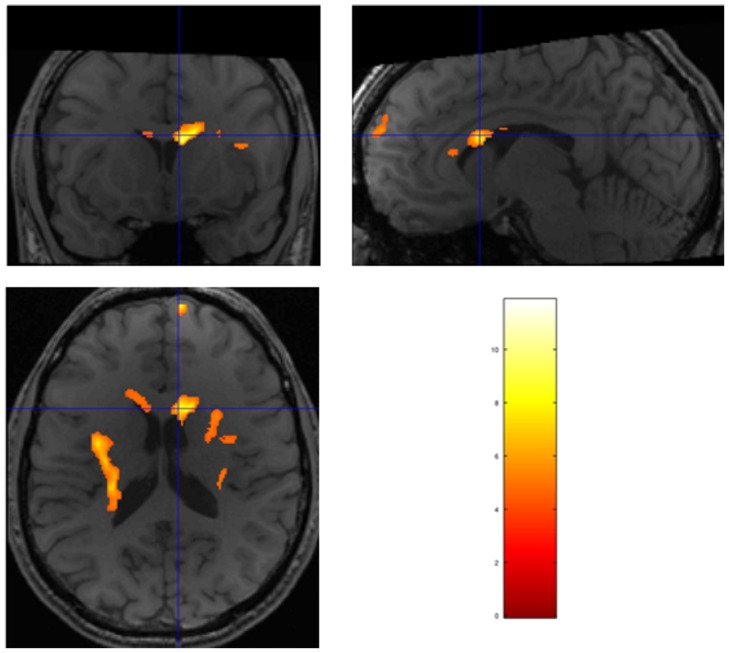
Two separate activation regions are seen within the corpus callosum for the group comparison using the 2nd level contrast NπS0 - N0Sπ, threshold p<.001, uncorrected for family-wise error (FWE).Because the activation maps have been smoothed at 8×8×8 mm FWHM, there may appear to be an overlap of the activation with the ventricle seen on the high resolution T1 image, which we did not attempt to mask. The statistics for this cluster is an indication that there exists at least one point of activation within the cluster with true significance (p<.01, FWE, cluster-wise for the larger region, Table 4). Obviously, the true source of activation would be in the tissue region, as the region of significance would likely be near voxels with the highest t-scores, which are located within the corpus callosum. The large activation seen in the L. insula is also cluster-wise significant (p<.01). All conditions were presented using random permutation ordering to prevent possible cyclic responses or habituation effects being mix with the contrast of conditions. Furthermore, SPMd was used to prevent any possible influence of outliers or motion.